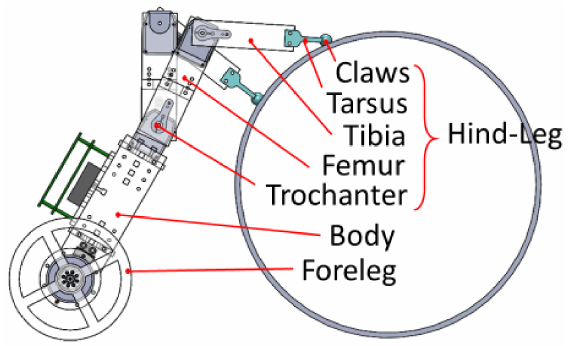
Figure 4. The Computer-aided design (CAD) model (side view) of the first version of dung beetle robot.